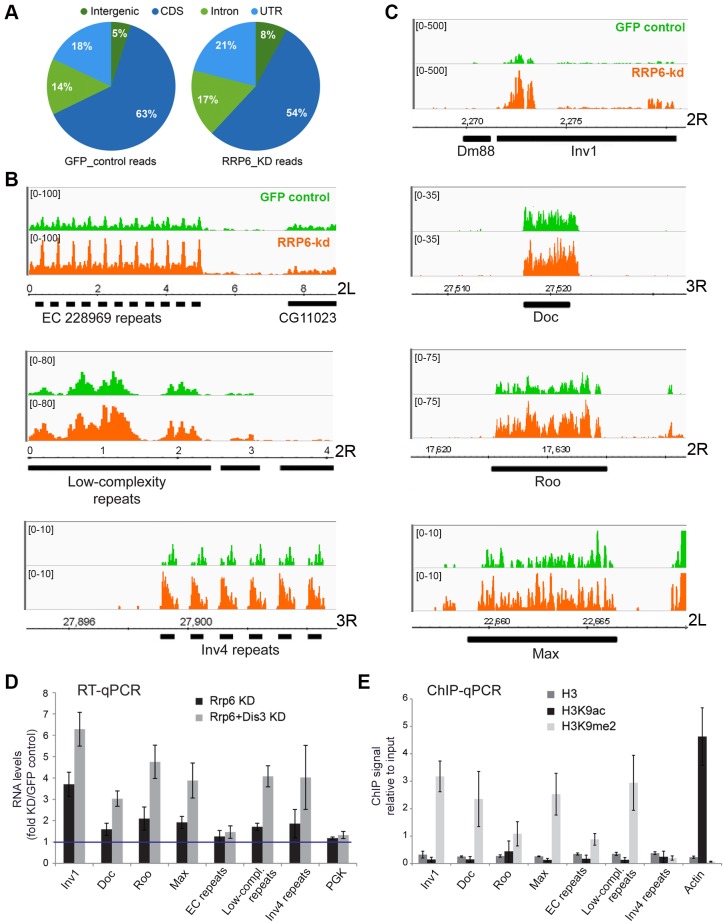
Genome-wide effects of RRP6 depletion on the transcriptome of S2 cells.The effects of RRP6 depletion on the steady-state expression levels were investigated by RNA-seq. Control experiments (GFP RNAi) were carried out in parallel and used as a reference. The expression levels in the control GFP cells and in RRP6-depleted cells expressed as reads per million (y-axis) are shown in green and orange, respectively. Genomic coordinates are indicated in the x-axis in B-C. (A) Pie diagram showing the effect of RRP6 depletion on the levels of different types of sequences, as indicated. (B) Examples of the effect of RRP6 depletion on the expression of repeat sequences. The upper and lower panels show subtelomeric regions of chromosome arms 2L and 3R, respectively, and the middle panel shows a region near the 2R centromere. (C) The effect of RRP6 depletion on the expression of selected transposon sequences. The genomic position of each sequence is indicated in the x-axis. (D) RNAi experiments were carried out to knock down RRP6 alone or RRP6 and DIS3 simultaneously. RNA was isolated and analysed by RT-qPCR using primer pairs designed to amplify selected sequences (the primer sequences are provided in the Supplementary Materials and Methods). The data was normalised to actin 5C RNA levels and expressed as a fold change compared to the levels observed in the GFP control. A protein-coding gene, Pgk, was analysed in parallel as a control. The histogram shows averages and standard deviations from three independent biological replicates. (E) ChIP experiments with antibodies against histone H3, H3K9ac, and H3K9me2 were carried out in untreated S2 cells to analyze the chromatin state of the selected genomic regions. Actin 5C was analyzed in parallel as a representative for euchromatin. The histogram shows averages and standard deviations from three independent biological replicates.